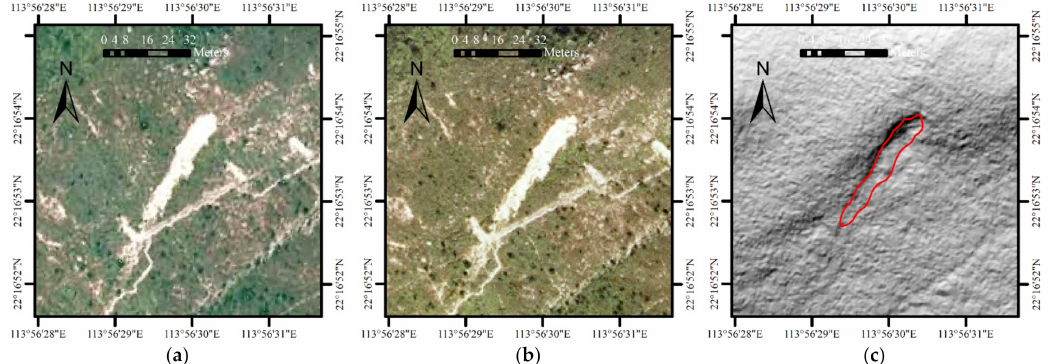
Figure 9. Illustration of the validity of DEM and aerial image in this study. ( a ) Aerial image taken in November 2008; ( b ) Aerial image (taken in November 2011) used for visual validation in this study; ( c ) The DEM (from LiDAR data obtained in 2010) derived hill-shade image, and the outlines of the identified landslides are sketched in red